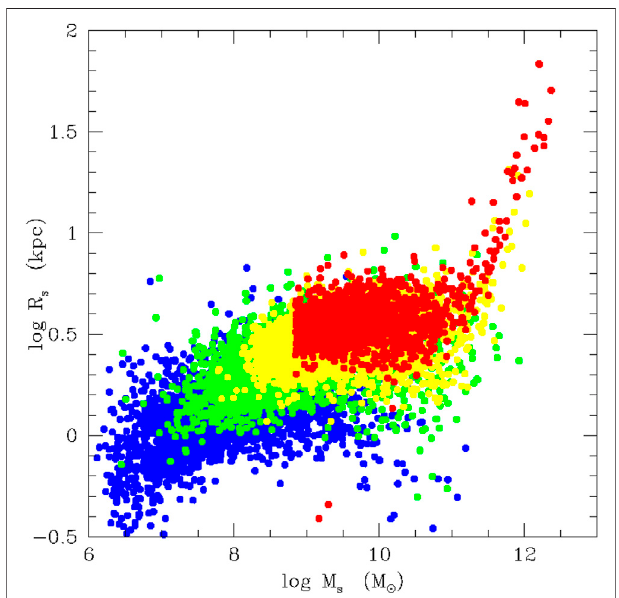
FIGURE 5 | The stellar half-mass radius R e plotted vs the total stellar mass M s of galaxy models from the Illustris database at different values of the redshift, i.e. z (cid:1) 4 (blue), z (cid:1) 2 (green), z (cid:1) 1 (yellow), and z (cid:1) 0